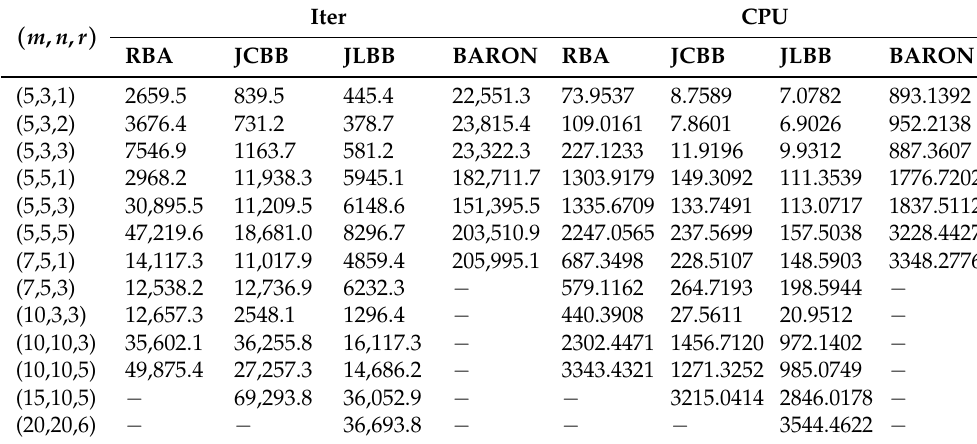
Table 2. Numerical results in Example